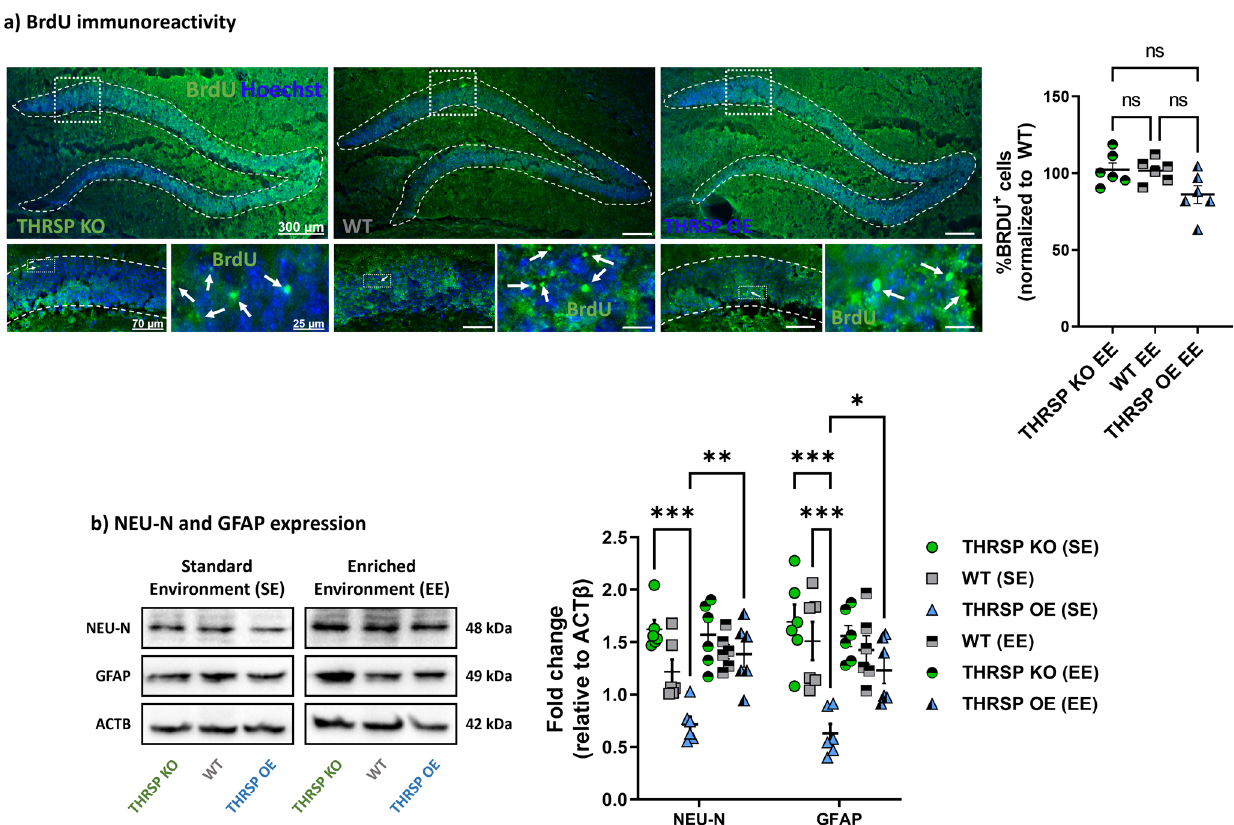
Fig. 9 The BrdU, NEU-N, and GFAP immunoreactivity in mouse hippocampal DG after environmental enrichment and treadmill exercises. a BrdU immunoreactivity and b protein expression levels of NEU-N and GFAP in the mouse hippocampal DG. ( n = 6 mice/group; a one-way ANOVA, F ( = 4.02, P = 0.040; b two-way ANOVA, SE/E exposure per strain: F ( 2, 15 ) exposure per strain × Protein targets: F ( 5, 60 ) = 0.820, P = 0.540). Values are presented as the mean ± SEM. Enriched environment and treadmill exercises improve in NSC activity in THRSP via the normalization of neurogenic markers. DG dentate gyrus, EE enriched environment, NSC neural stem cell, SE standard environment, THRSP thyroid hormone-responsive